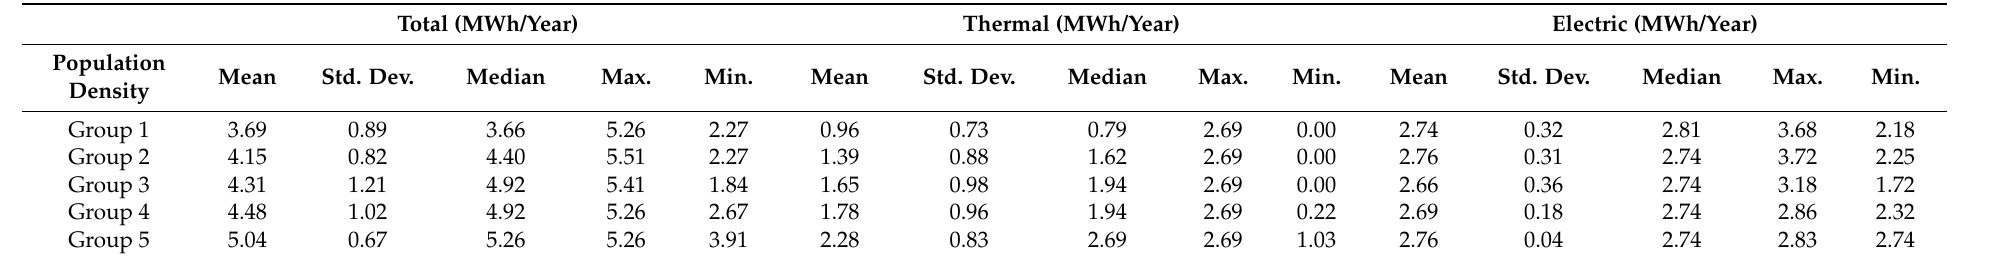
Table 4. Statistical data of energy consumptions per inhabitant by group of cities without the influence of climate. Total (MWh/Year) Thermal (MWh/Year) Electric (MWh/Year) Population Mean Std. Dev. Median Max. Min. Mean Std. Dev. Median Max. Min. Mean Std. Dev. Median Max. Density